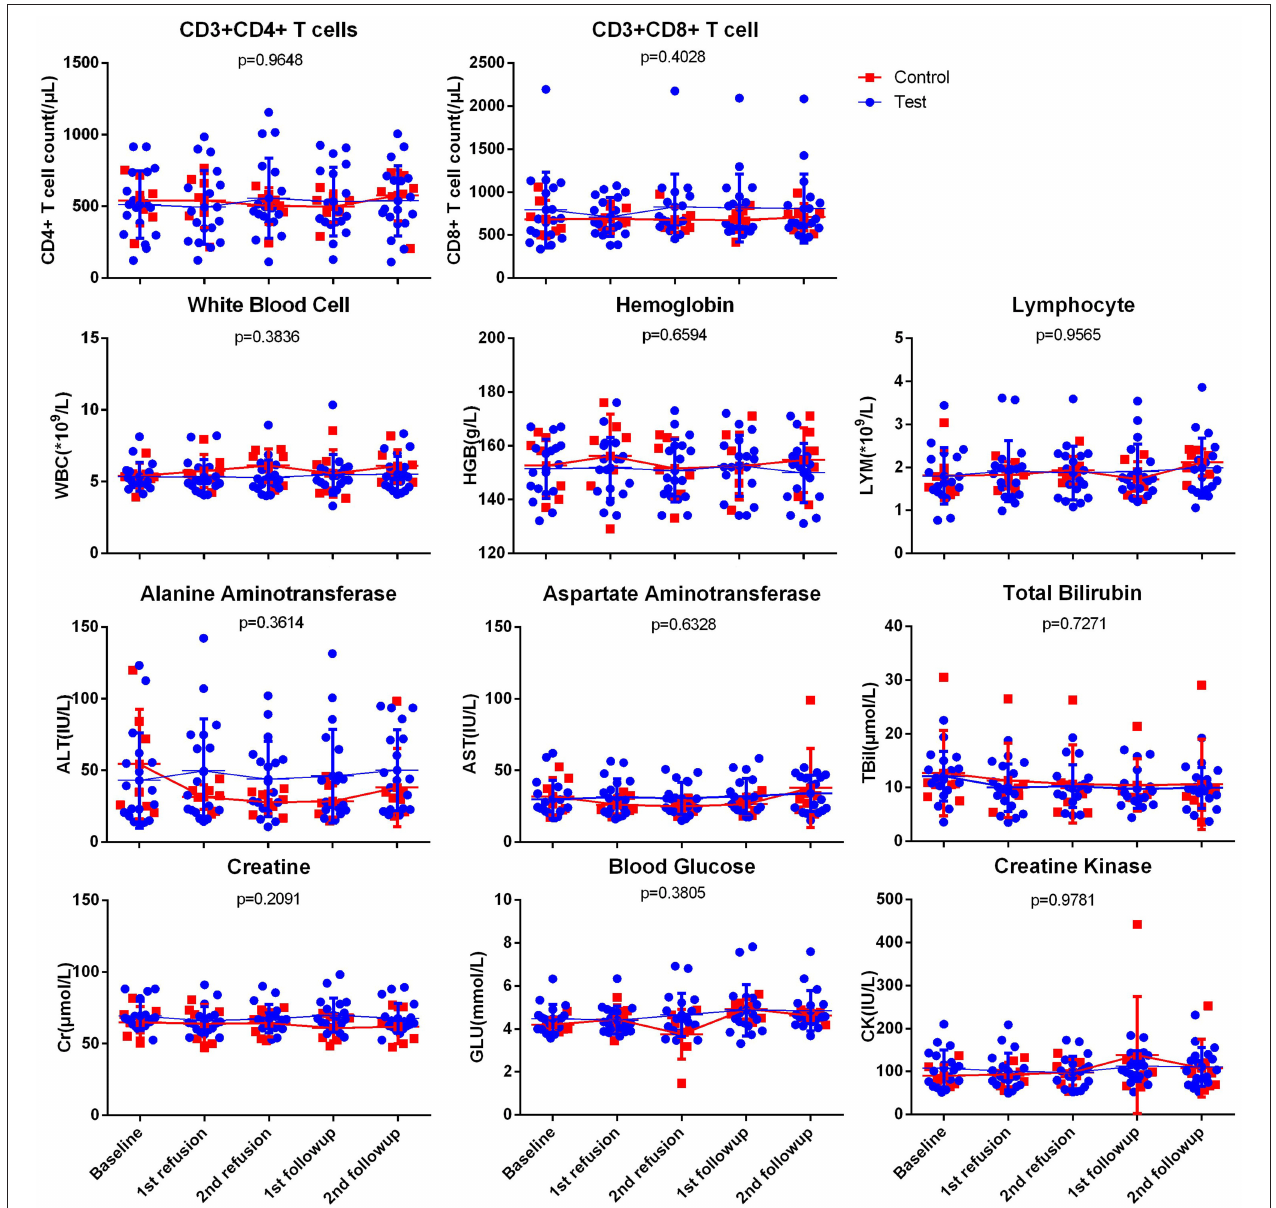
FIGURE 2 | The changes of all the parameters of laboratory evaluations of safety. Each dot represents an individual data, the horizontal line on each set of data represents the standard deviation of the values. WBC, White blood cell; HGB, Hemoglobin; LYM, Lymphocyte; ALT, Alanine Aminotransferase, AST, Aspartate Aminotransferase; TBil, Total Bilirubin; Cr, Creatine; GLU, Blood Glucose; CK, Creatine